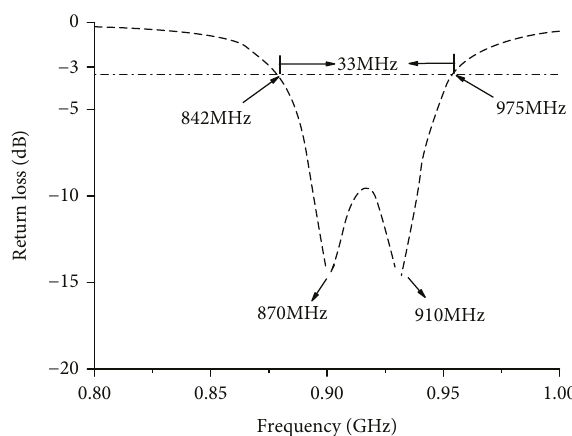
= 8 2 mm, and W = 1 6 mm). (b) Input resistance curves of the antenna with di ff erent gap loop gap = 8 2 mm, and L = 47 2 mm). loop loop